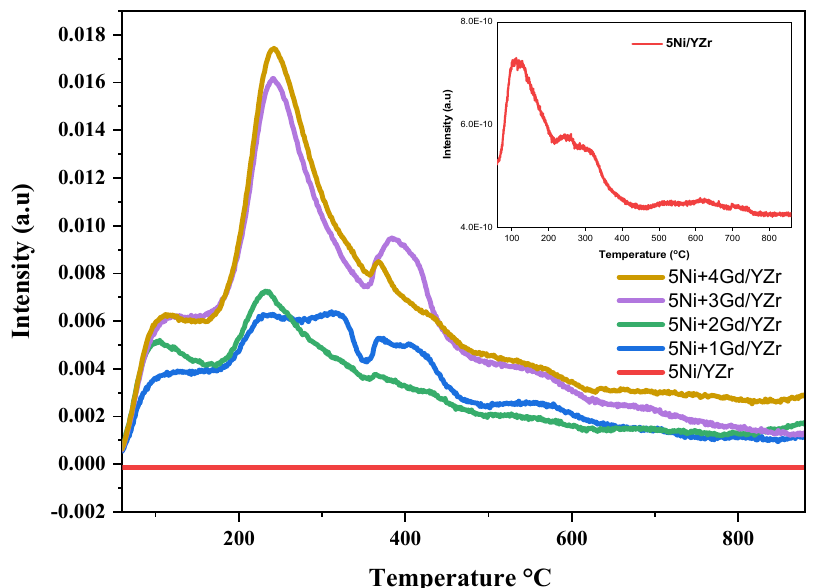
Figure 3. CO 2 − TPD profiles of the fresh catalysts (inset Figure: CO 2 -TPD of 5Ni/YZr added for clarity because of its very weak TCD intensity).